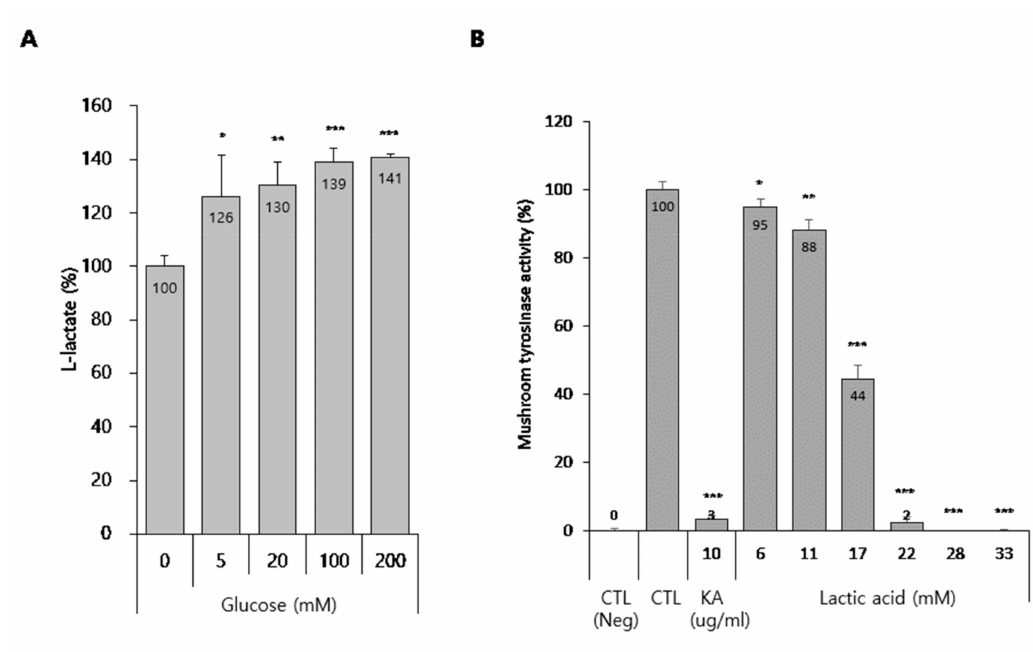
Figure 5. Production of lactate by glucose and e ff ect of lactic acid on the tyrosinase activity. ( A ) Lactate production in glucose-treated B16 cells. ( A ) B16 cells were treated with the indicated concentrations of glucose for 3 d. Then, a lactate assay was performed using the cultured media, as described in the methods section. ( B ) E ff ect of lactic acid on the mushroom tyrosinase activity in cell-free system. Data are expressed as the mean ± SD of at least three independent measurements (* p < 0.05, ** p < 0.01, *** p <